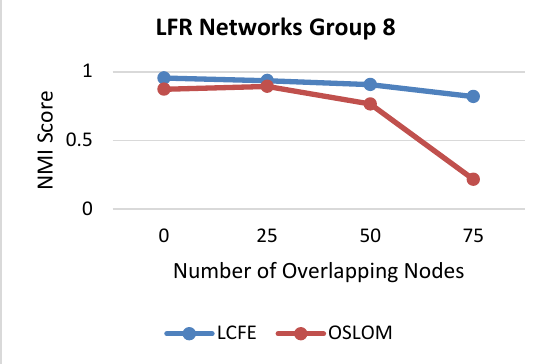
Fig. 9. NMI score comparison for LCFE and OSLOM for seventh group of LFR Networks with number of overlapping nodes ranging from 0 to 75